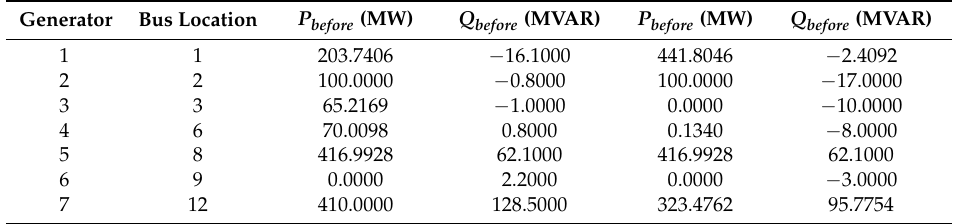
Table 2. The generator outputs before and after the remedial action in scenario